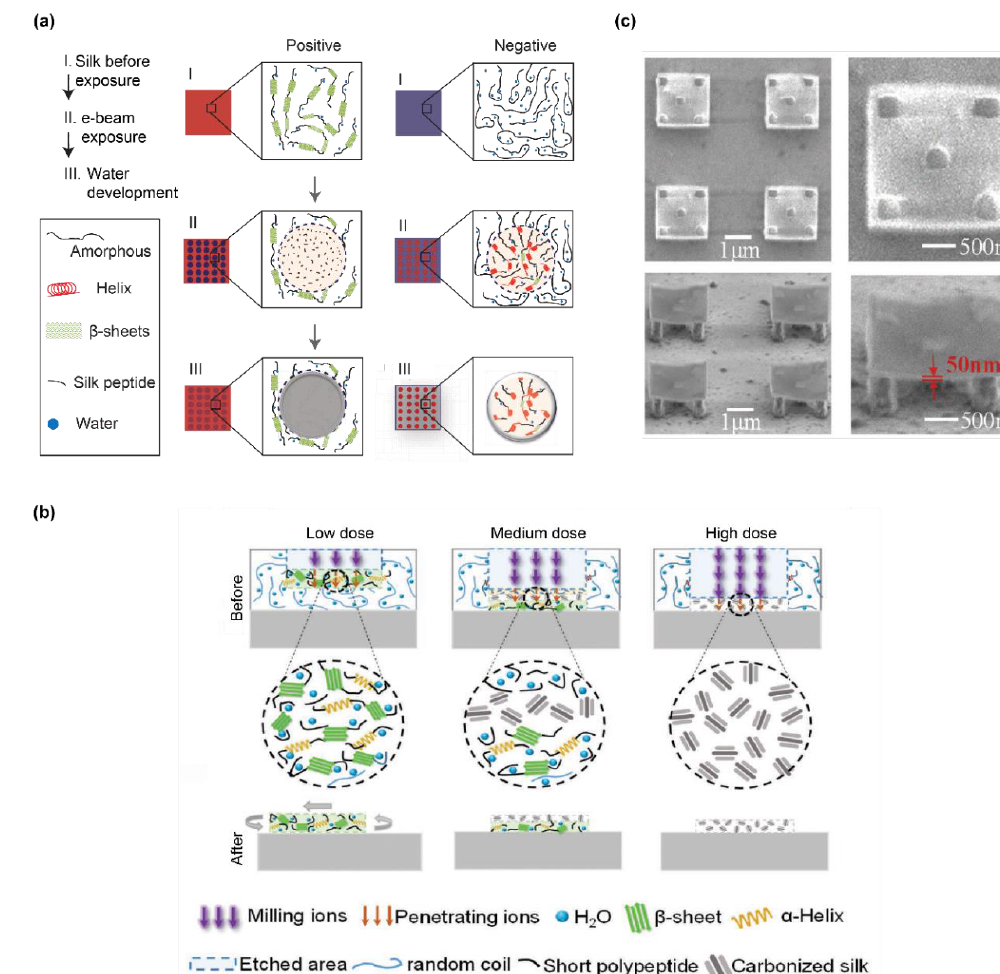
Figure 6. ( a ) Polymorphic conformation of silk fibroin has been employed for positive and negative lithography via electron beam. Reproduced with permission from Reference [115]. Copyright 2014 Springer Nature. ( b ) Dose of ion beam leads to di ff erent conformational transitions and structures. Reproduced with permission from Reference [117]. Copyright 2018 John Wiley and Sons. ( c ) SEM images of 3D desks with four pillars via the combination of ion and electron beams. Reproduced with permission from Reference [117]. Copyright 2018 John Wiley and